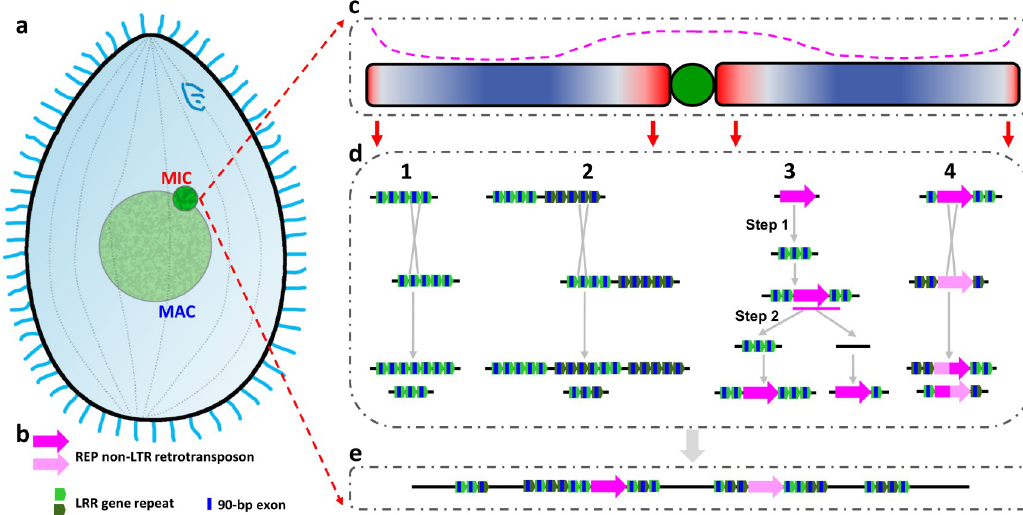
Fig 9. Evolutionary model of the observed innovation in LRR genes with tandem 90-bp exons. (a) Diagram of a Tetrahymena cell. (b) Key to LRR gene-related symbols. (c) Typical MIC chromosome showing the biased distribution of key genetic elements. Central green circle: centromere (not yet fully assembled and characterized). Red and blue shading: biased chromosomal distribution of youngest and most conserved genes, respectively. Darkest color: highest concentration. Pink dashed line above the chromosome: biased chromosomal distribution of TEs, REP included, and other repeated sequences. (d) Multiple exon-shuffling mechanisms proposed to explain how pericentromeric and subtelomeric regions of the MIC genome function as LRR gene innovation centers. (1) Unequal crossing over between 2 different exons of the same LRR gene leads to alleles with more and fewer tandem repeats. (2) Unequal crossing over between exons in 2 different LRR genes leads to exon duplications and deletions. (3) REP retrotransposition into a preexisting LRR gene (step 1), followed by possible (not yet demonstrated) REP -mediated retrotransduction of LRR gene repeats into another LRR gene (step 2) would lead to a net increase in number of LRR gene repeats. Pink line: transcript resulting from cotranscription of REP and 1 LRR gene repeat. Note that the right branch of represents a co- retrotransposition of REP and an LRR repeat, which lead to dispersal of the LRR repeats and could potentially mediate further ectopic recombinations. (4) REP copies, also being repeated sequences, can undergo unequal crossing over, with similar consequences as mechanism 2. (e) Representative product of the above mechanisms: LRR gene with long tandem arrays of 90-bp exons. LRR, leucine-rich repeat; MAC, macronucleus; MIC, micronucleus; non-LTR, Non-long terminal repeat; REP , REP-type retrotransposon; TE, transposable element.